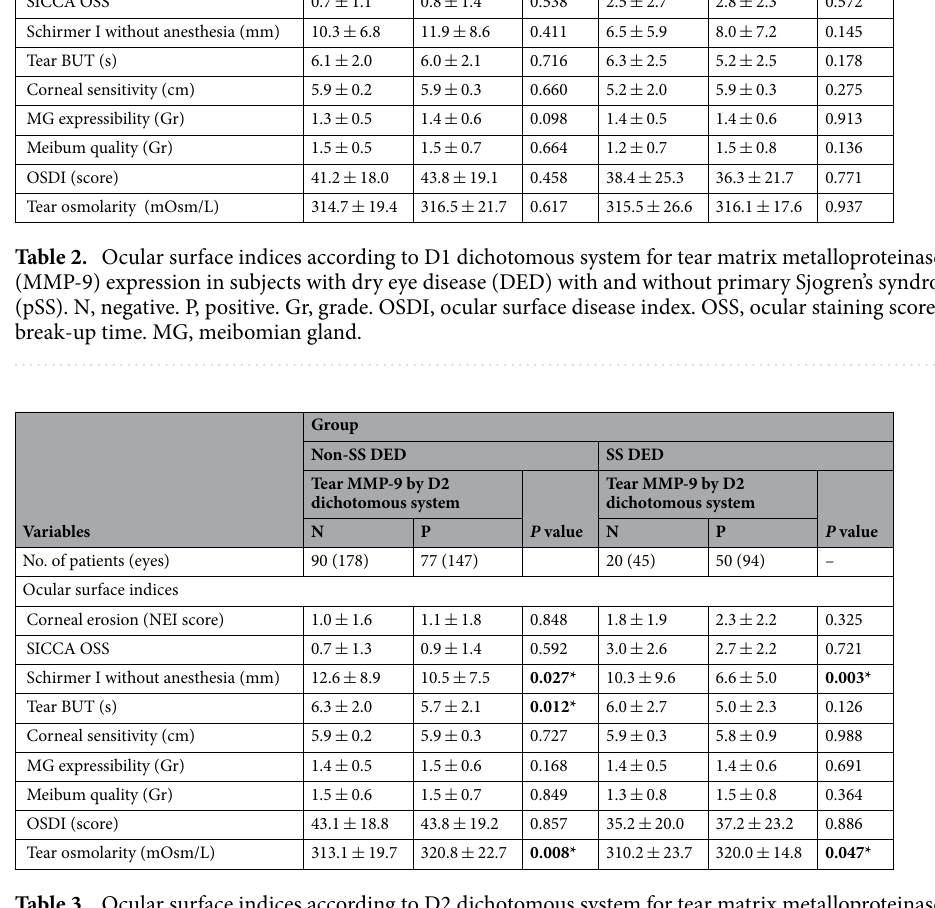
Table 3. Ocular surface indices according to D2 dichotomous system for tear matrix metalloproteinase 9 (MMP-9) expression in subjects with dry eye disease (DED) with and without primary Sjogren’s syndrome (pSS). * P < 0.05. N, negative. P, positive. Gr, grade. OSDI, ocular surface disease index. OSS, ocular staining score. BUT, break-up time. MG, meibomian gland. Significant are in value